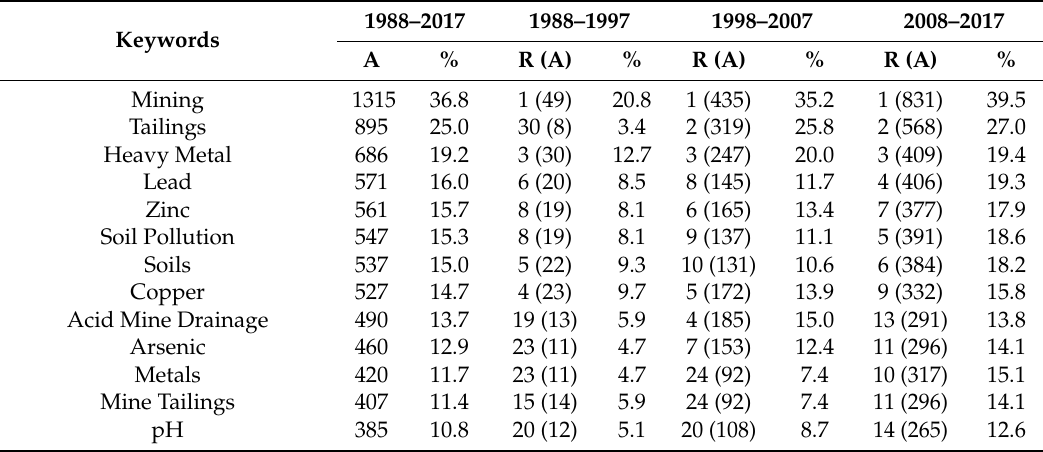
Table 7. Most frequently used keywords in MW research.